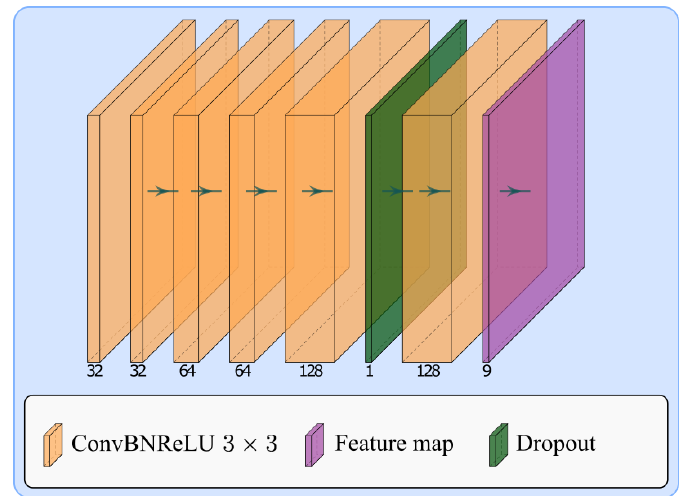
Figure 5. CNN architecture of the Deep Dense Feature Network.